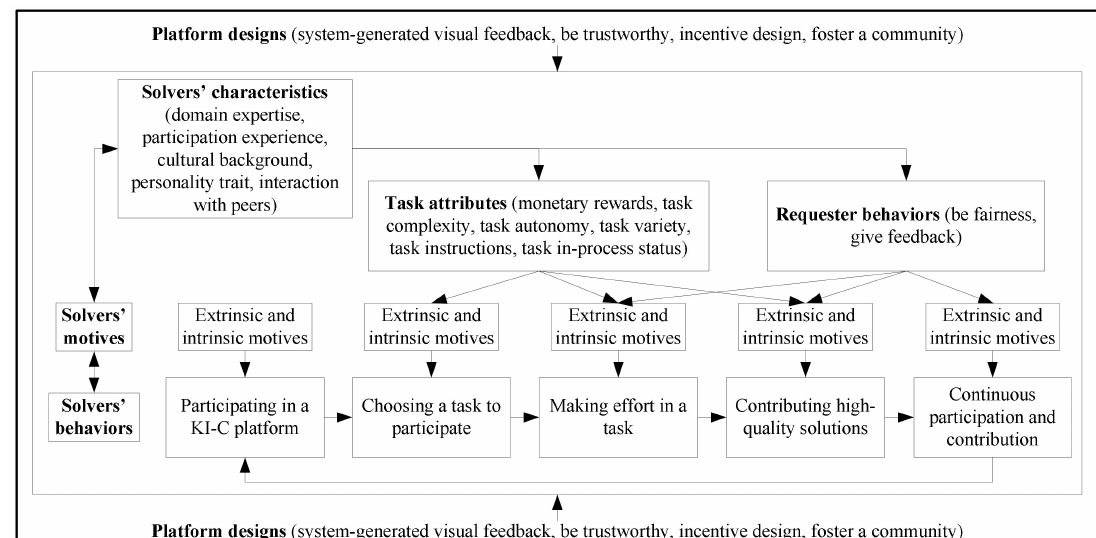
Figure 1. A framework for demonstrating the roles of the identified